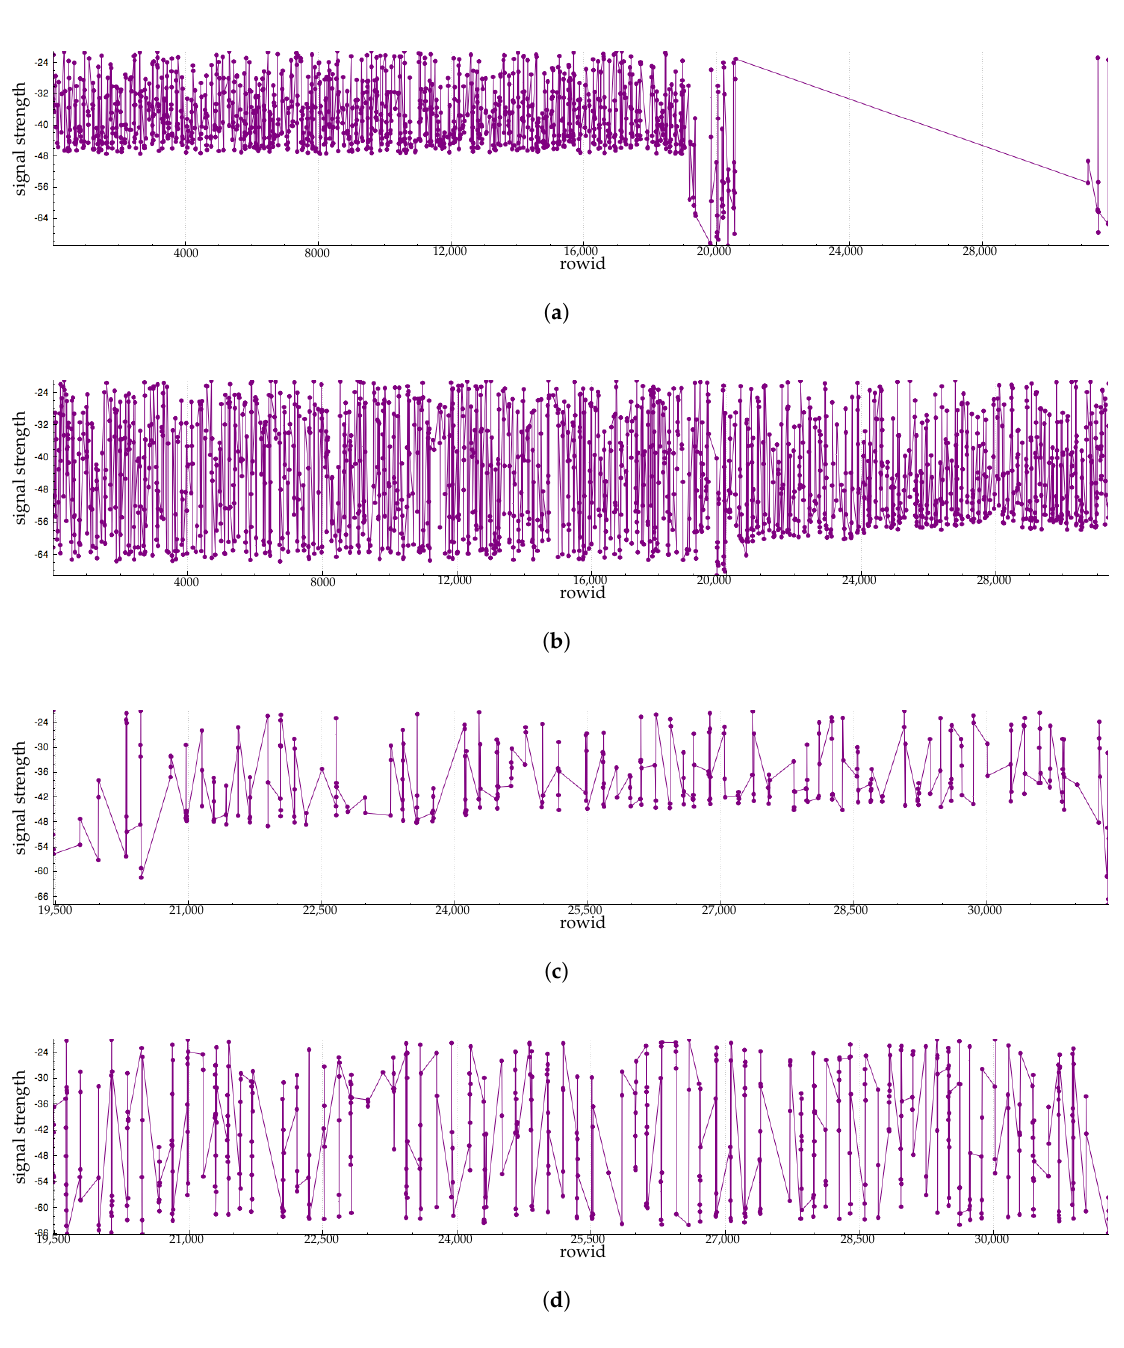
Figure 16. Sample of charts of RFID antenna signal strength for the tag named “TagMug”. This is the raw data of signal strength. ( a ) Antenna RFID1; ( b ) Antenna RFID2; ( c ) Antenna RFID3; ( d ) Antenna